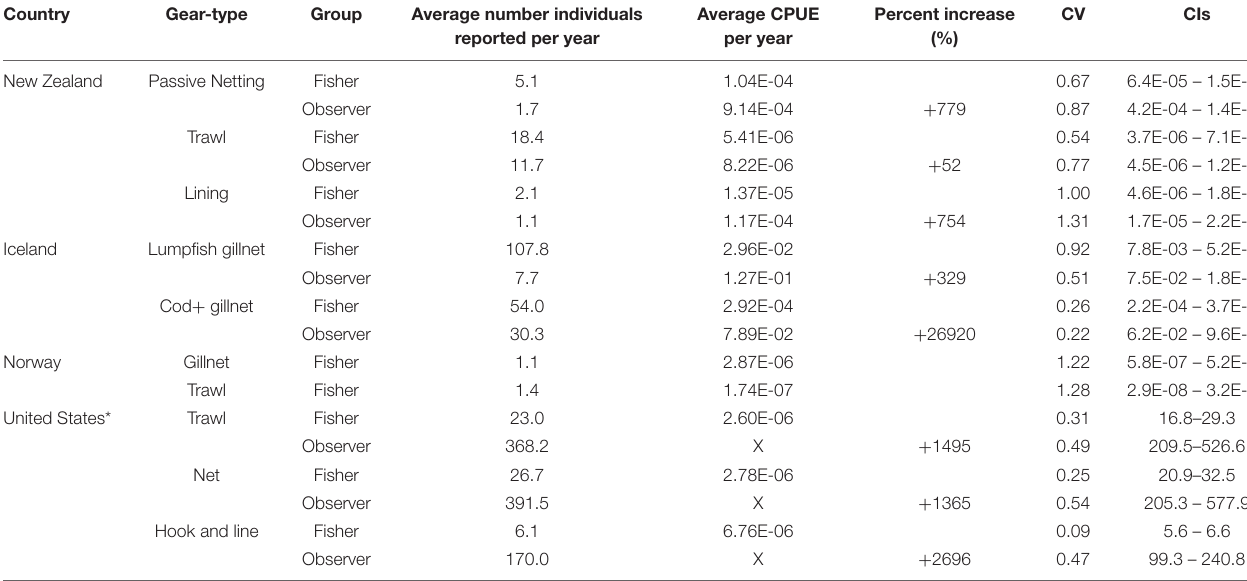
TABLE 1 | Average annual number of individual cetaceans reported as bycatch per year, average annual catch per unit effort (CPUE) based on 100 kg fish caught (New Zealand, Norway, United States), number of trips (Iceland lumpfish gillnet) or net-nights (Iceland cod + gillnet), coefficient of variance (CV), and 95% confident intervals (CIs) calculated based on fisher logbook data and observer data CPUEs for each country and each gear type for which the average annual number of cetaceans caught was at least 1